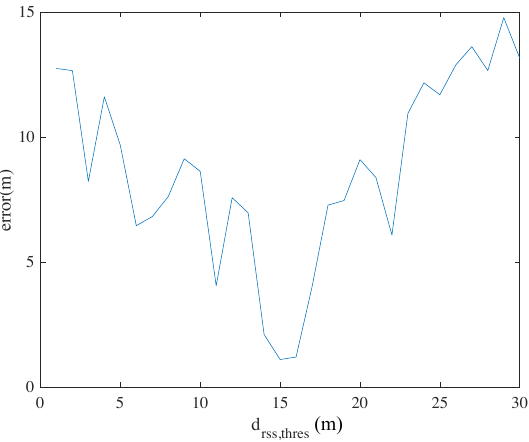
Figure 6. The mean positioning errors of the proposed method according to different values of d thres , rss